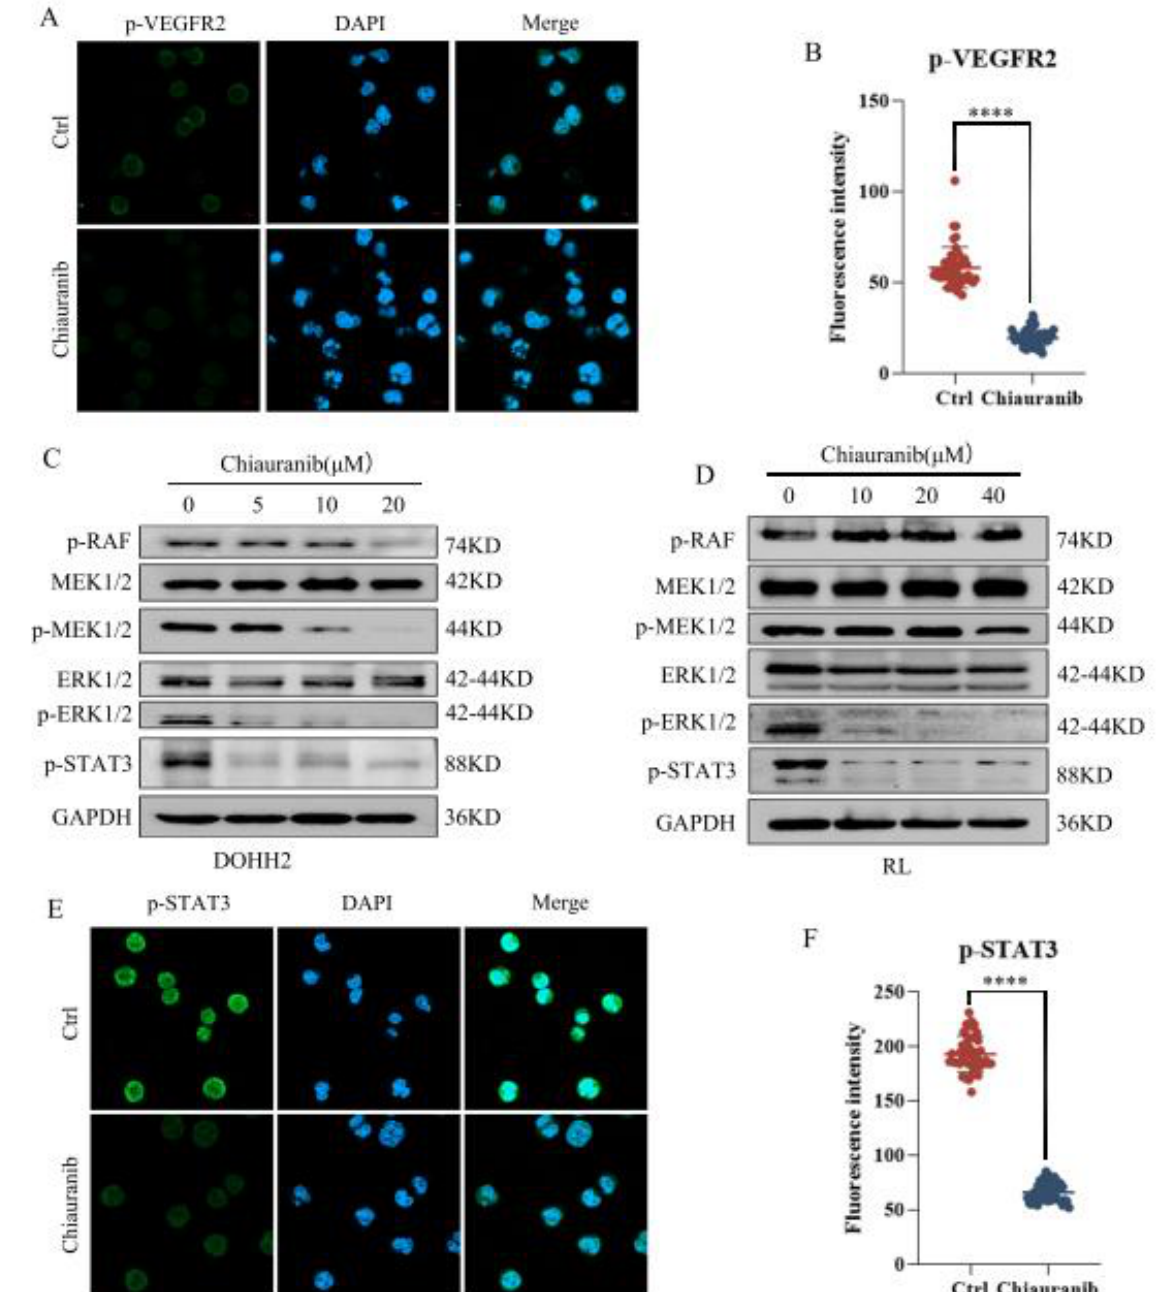
Figure 4. Chiauranib inhibits the VEGFR2/MEK/ERK/STAT3 signaling pathway. ( A ) Immunofluorescence shows that chiauranib administration (40 µM) for 24 h alters the phosphorylation levels of VEGFR2 in DOHH2 cells (proportional scale 1:100 pixel). ( B ) Data from at least three independent experiments. Western blotting assay to detect protein expression after chiauranib treatment in ( C ) DOHH2 and ( D ) RL cells for 24 h. After treatment with chiauranib (40 µM) for 24 h, the changes in the phosphorylation levels of STAT3 were examined by ( E ) immunofluorescence (proportional scale 1:100 pixel) and ( F ) data analysis (**** p < 0.0001).